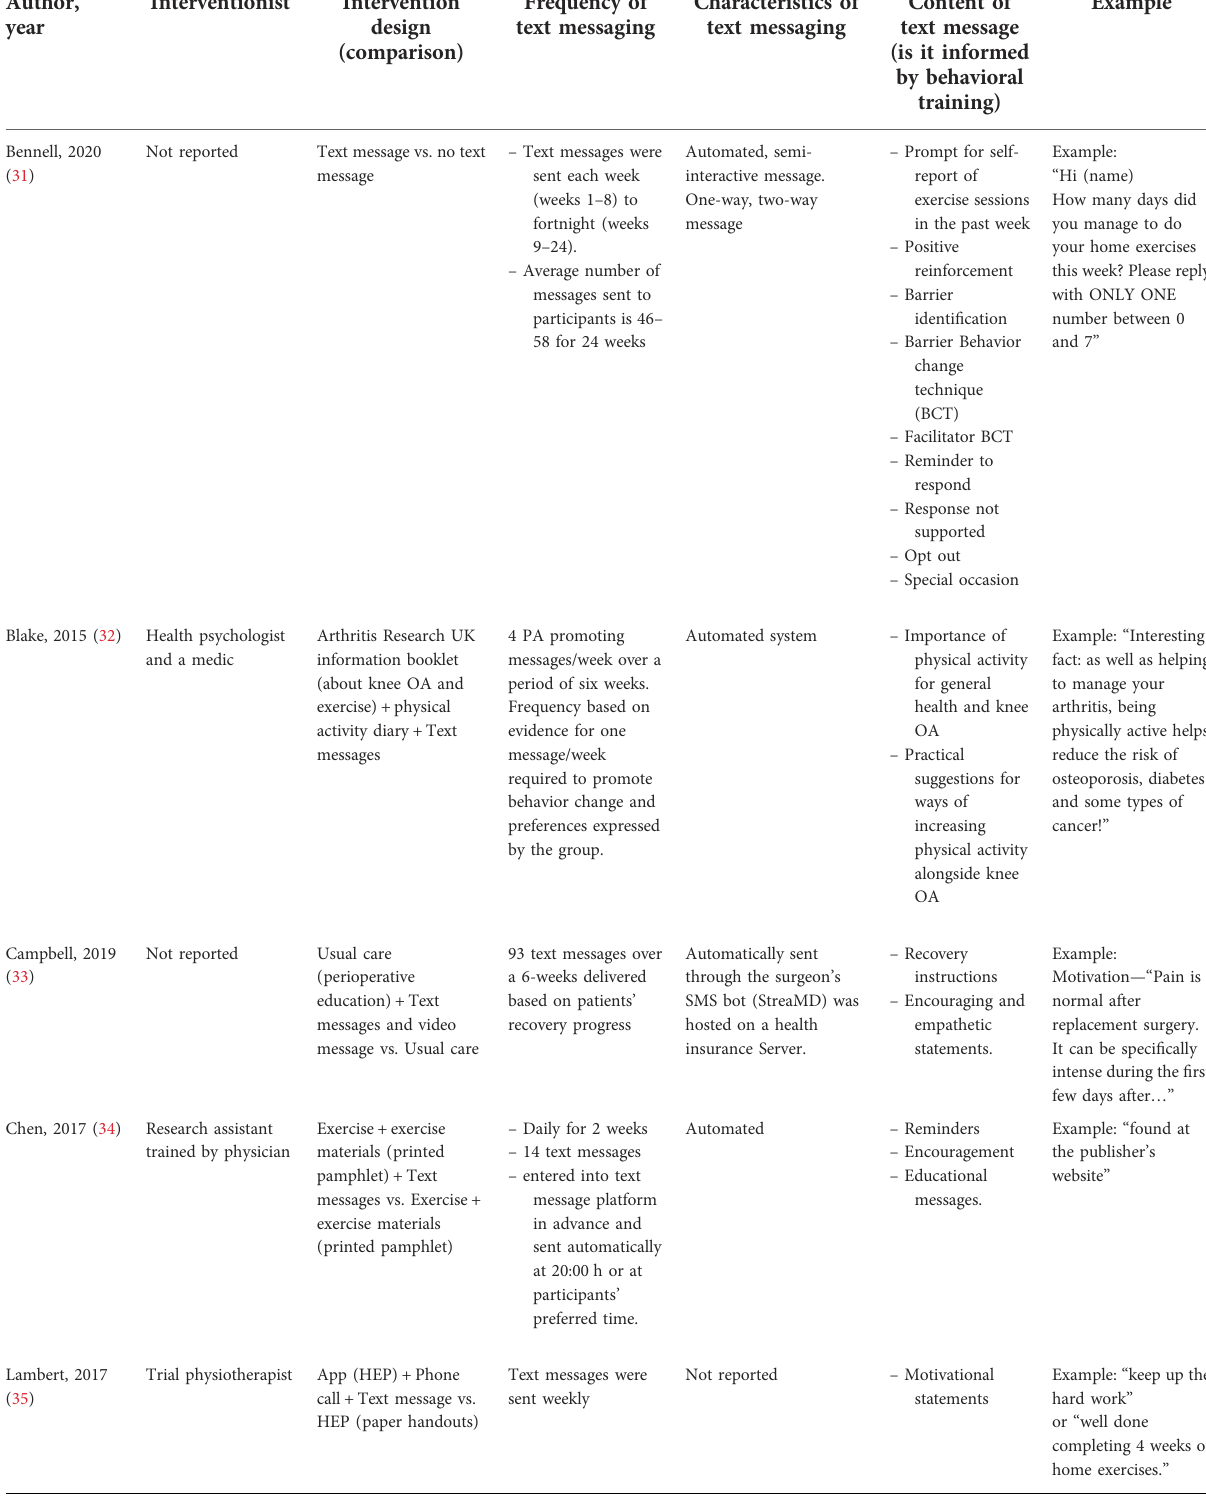
TABLE 2 MSK exercise, physical activity or rehabilitation interventions that informed Our design for incorporating text messages